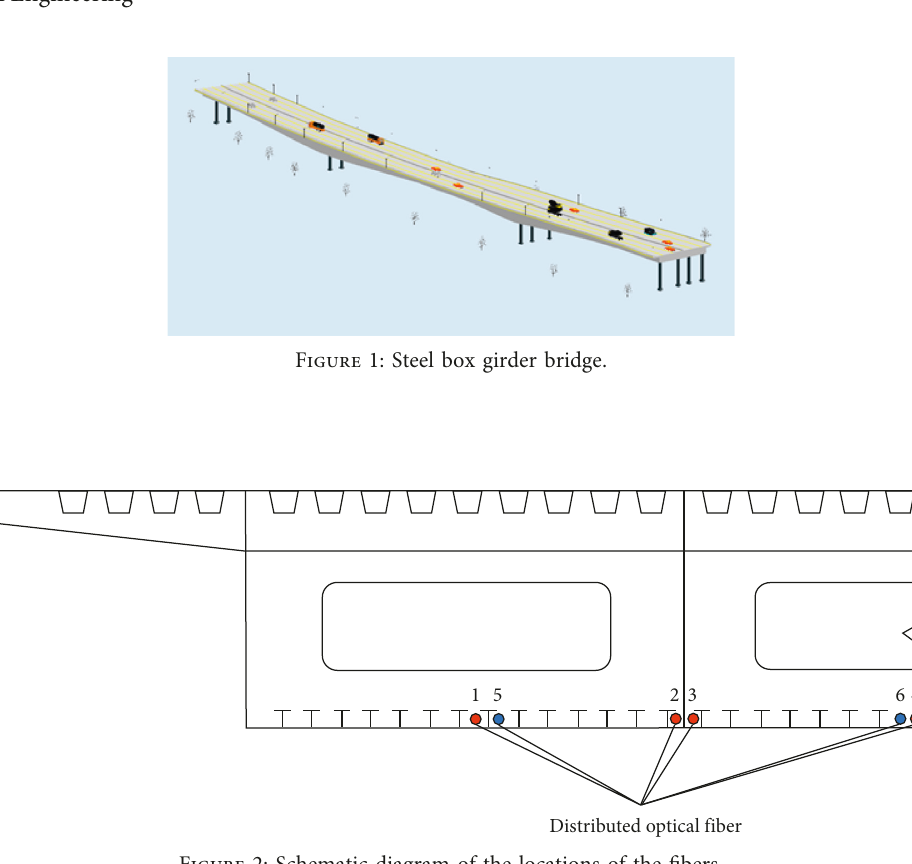
Figure 2: Schematic diagram of the locations of the fibers.